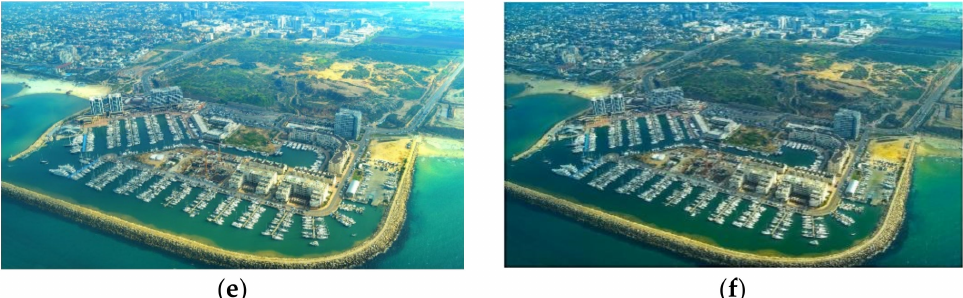
Figure 16. A comparison of defogging effects of foggy country images A comparison of defogging effects of foggy port images. ( a ) Image of foggy port image; ( b ) Tarel’s method; ( c ) He’s method; ( d ) Tufail ’s method; ( e ) Gao ’s method; ( f ) our method.